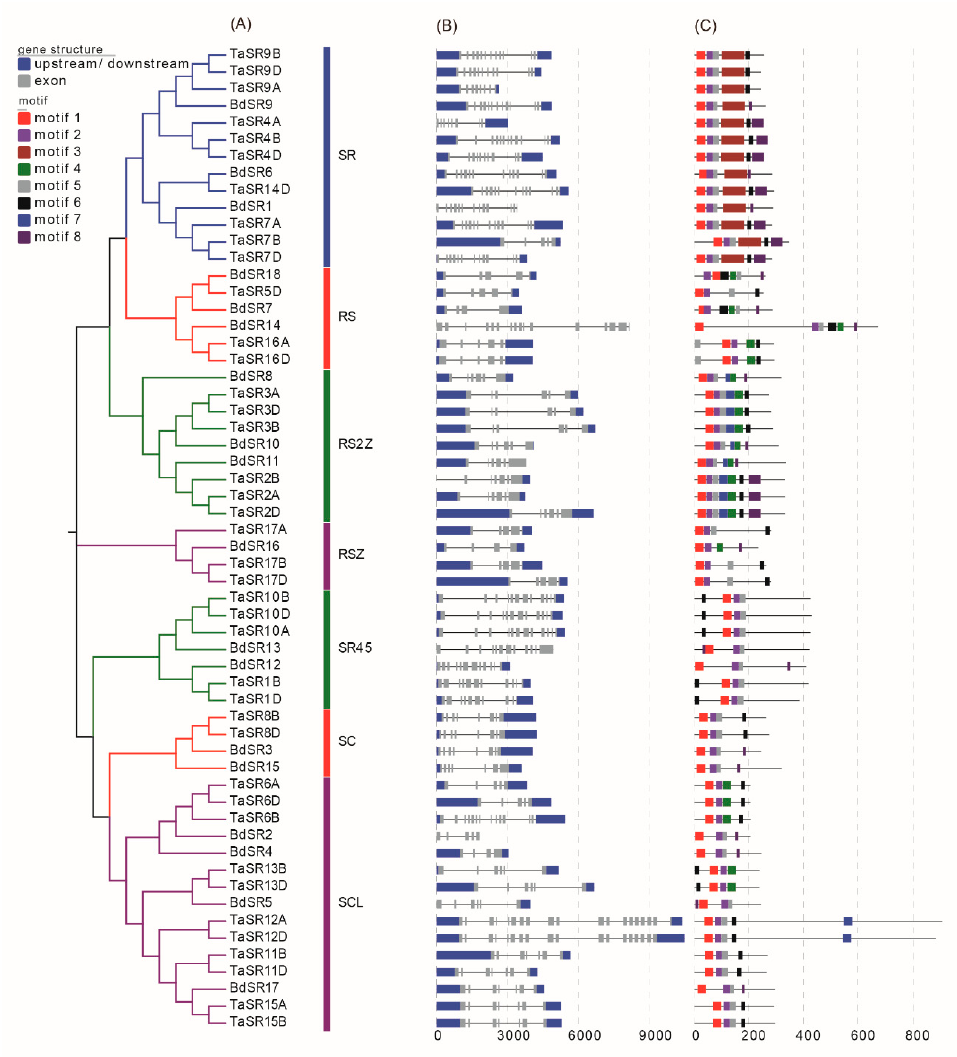
Figure3. Phylogeneticrelationships( A ),motifs( B )andgenestructure( C ).Thetreewasconstructedwith 1000 bootstrap replications using MEGA7 based on the full-length protein sequence. The exon–intron structures of these genes were graphically displayed by the Gene Structure Display Server. The MEME Suite web server was used to predict the conserved